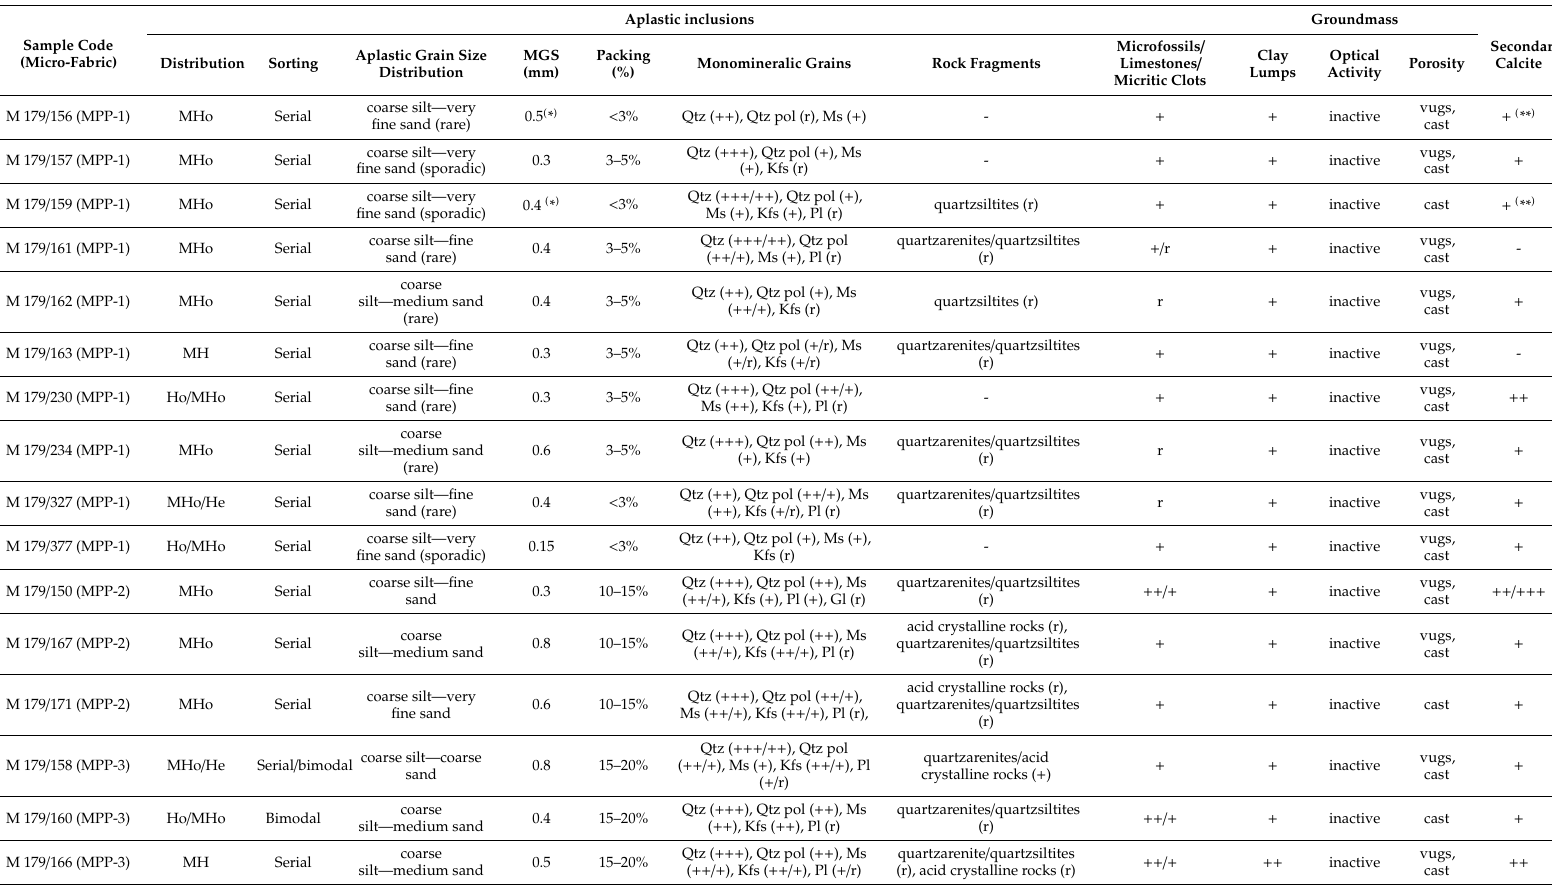
Table 2. Schematic description of the compositional and textural features of the studied western Greek amphorae. SampleCode